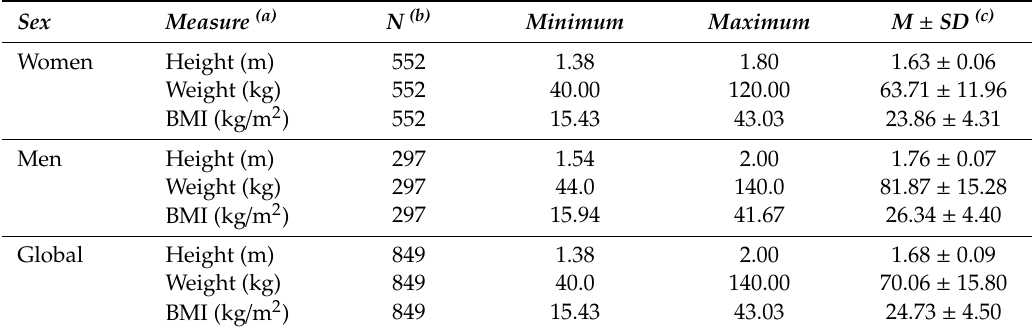
Table 2. Anthropometric measures of the participants.